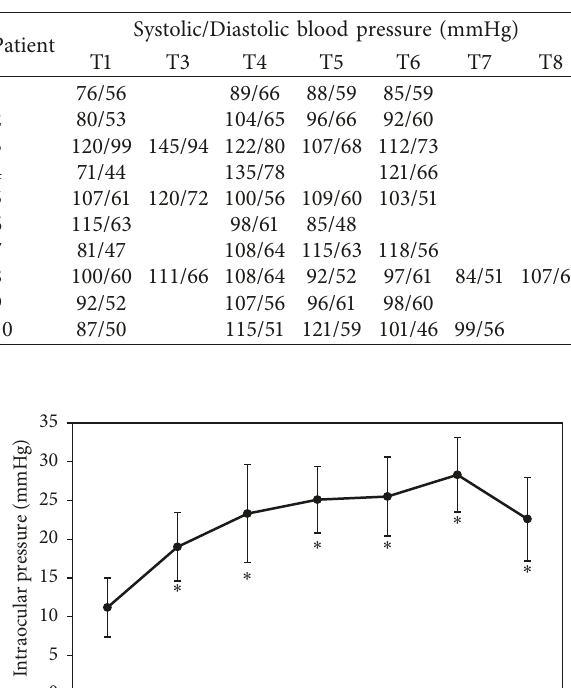
Table 2: Individual data for blood pressure